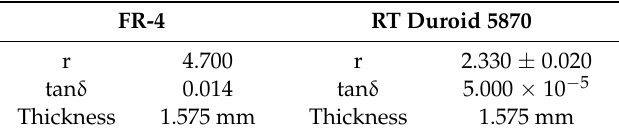
Table 2. FR-4 and RT Duroid 5870 substrate specifications